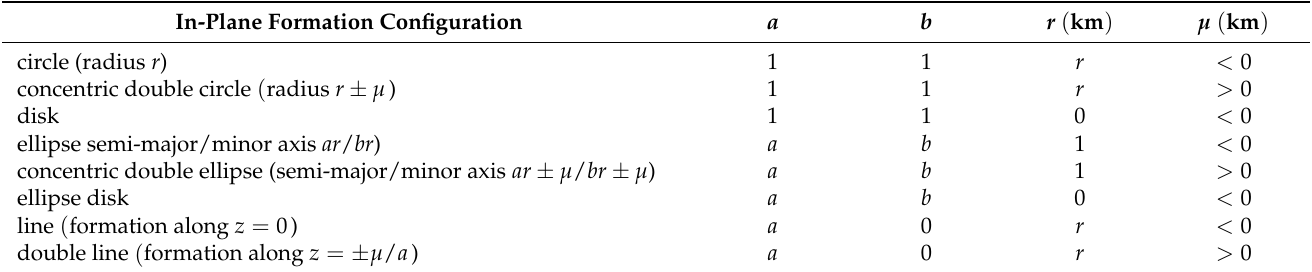
Table 1. In-plane formation configurations and bifurcating